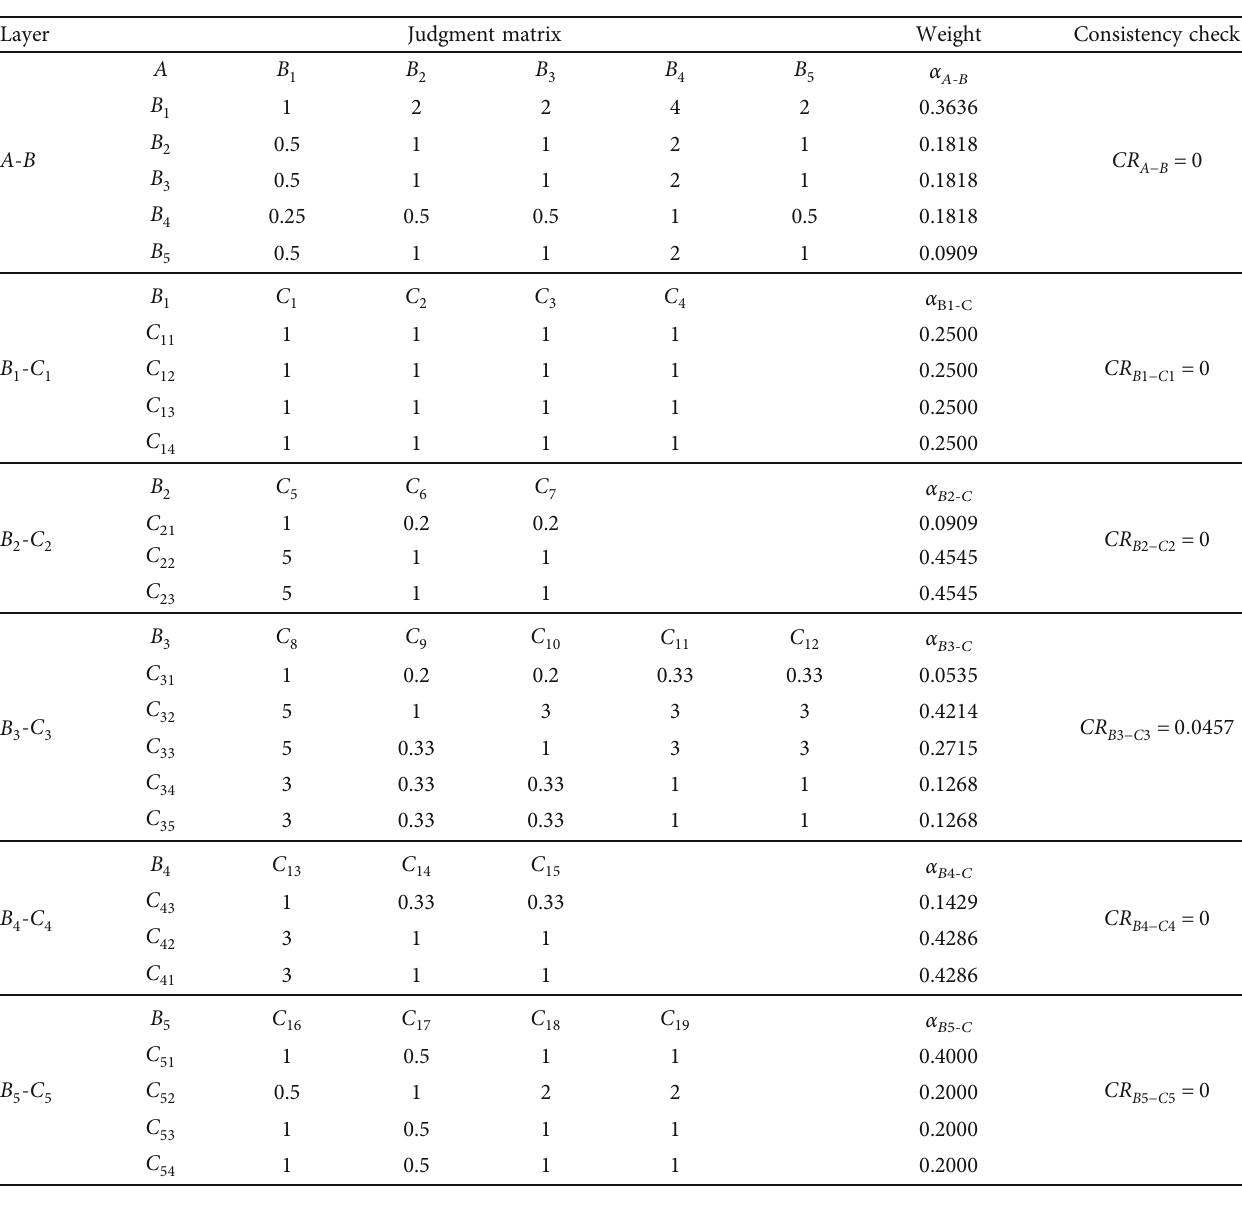
Table 13: Weight of index to criterion layer and consistency